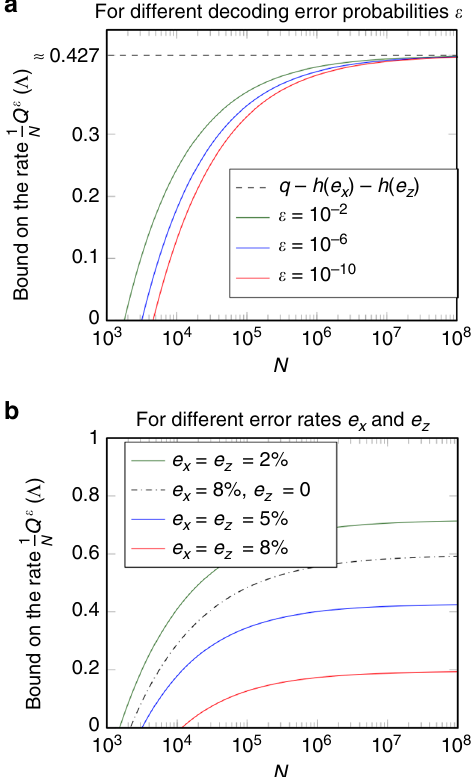
Fig. 5 Bound on the rate for the capacity estimation protocol as a function of the number of qubits. This fi gure shows the bound on the one-shot quantum capacity for the estimation protocol expressed as a rate, that is, the right hand side of inequality 9 divided by the number of qubits N . The plots show the bound as a function of N with the parameters as q = 1, and p = 1/2. a We plotted the bound for fi xed error rates e x = e z = 5% for a few different values of ε in order to visualize the dependence on the decoding error probability. The lower the allowed decoding error probability ε is set, the higher the number of qubits needs to be in order to get a positive bound on the rate (note that the N -axis is logarithmic). In the asymptotic limit N → ∞ , the bound converges to q (cid:5) h e x ð Þ (cid:5) h e z ð Þ . If q = 1, this coincides exactly with the (asymptotic) capacity for some important classes of channels, such as depolarizing channels. This shows that our bound is asymptotically optimal, and therefore, improvements are only possible in the fi nite-size correction terms. b To see the dependence on the error rates, we plotted our bound for a fi xed value of ε = 10 − 6 for a few different values of e x and e z . The higher the error rate, the higher the number of qubits needs to be in order to achieve a positive rate. For every pair of error rates e x and e z , the bound is monotonically increasing in N and converges to q (cid:5) h e x ð Þ (cid:5) h e z ð Þ . Therefore, the bound can only be positive when q (cid:5) h e x ð Þ (cid:5) h e z ð Þ is positive, which yields an easy criterion for the potential usefulness of a channel with known error rates (although the full version of the bound with the correction terms is not hard to evaluate